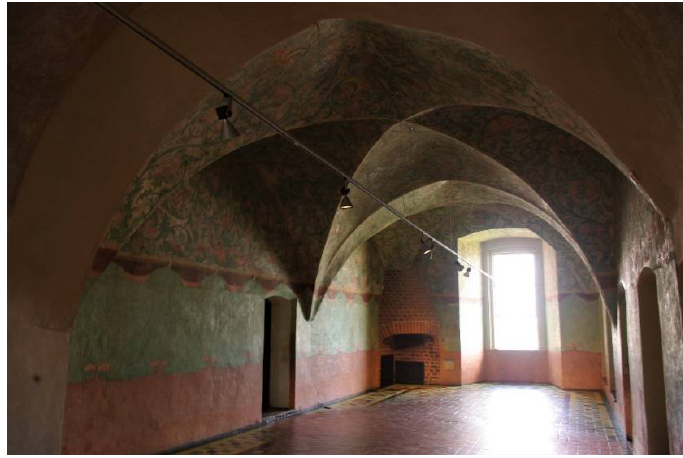
Figure 16. Malbork, Marienburg castle, Grand Master’s bedroom, probably 1380–1385. Photo by Tomasz Ratajczak, the author’s own work.